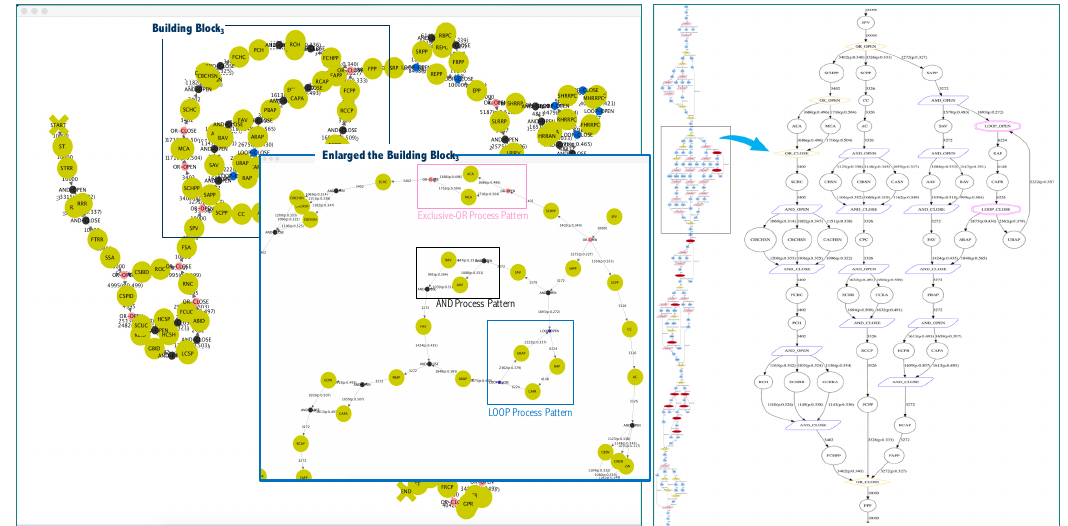
Figure 10. The rediscovered structured information control nets (SICN) process model from the Experimental Dataset-1.